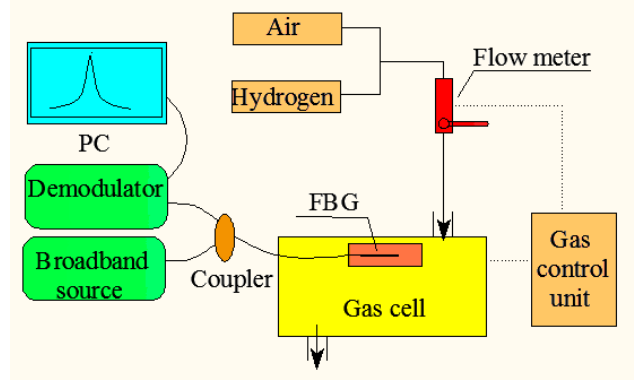
Figure 5. Experimental setup of hydrogen gas measurement.